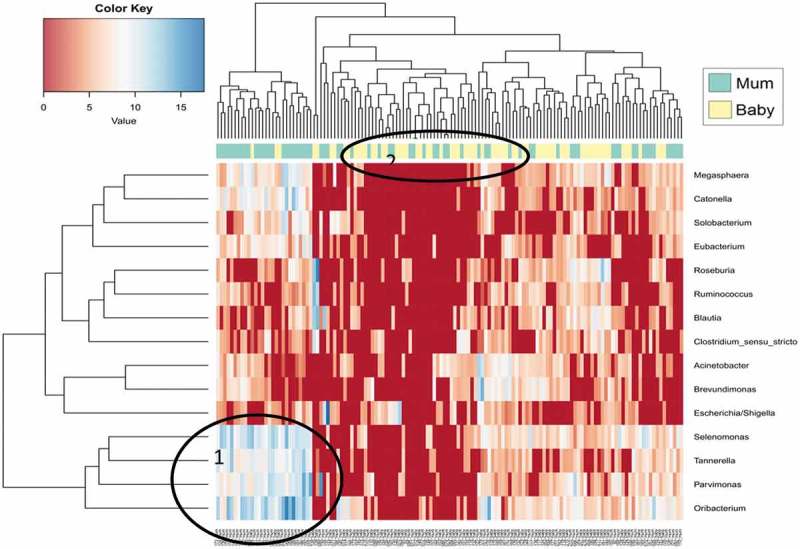
Hierarchical clustering of data between maternal saliva microbiota and infant oral microbiota at bacterial genus level. Abundances are colour-coded according to the colour key on the top left with red representing a value of zero. Euclidean distance and complete linkage were used to cluster the rows and columns of the heatmap. The colour bar on side of the heatmap corresponds to sample type (green = mother, yellow = infant). All taxa present at less than 1% in all three groups are excluded from the heatmap.